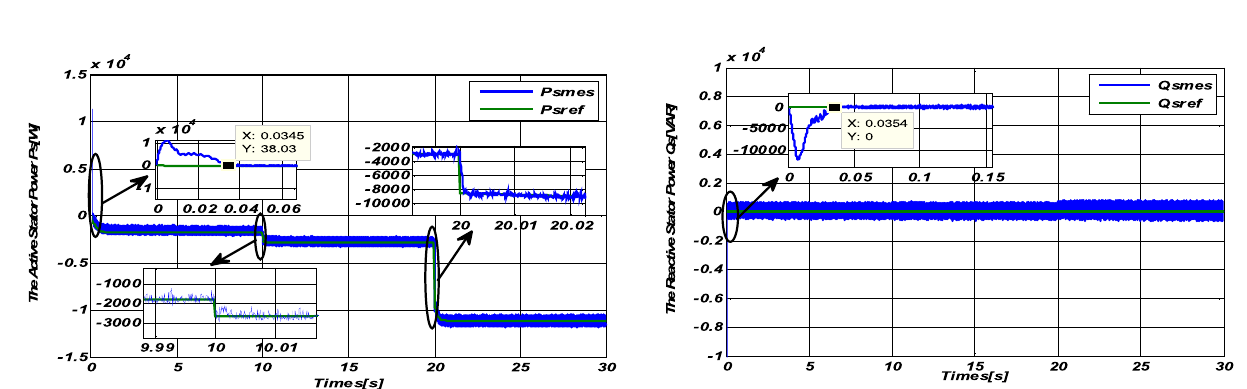
Figure 7. Robustness test with variation of resistances Rr and Rs for step wind speed.